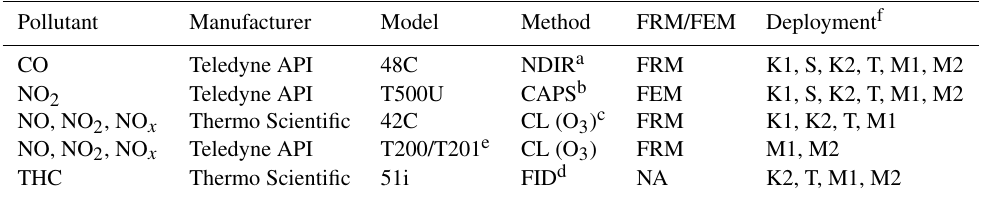
Table 2. Additional measurement methods operated during the present study. Pollutant Manufacturer Model Method FRM/FEM Deployment f CO Teledyne API NO 2 Teledyne API T500U NO, NO 2 , NO x Thermo Scientific NO, NO 2 , NO x Teledyne API